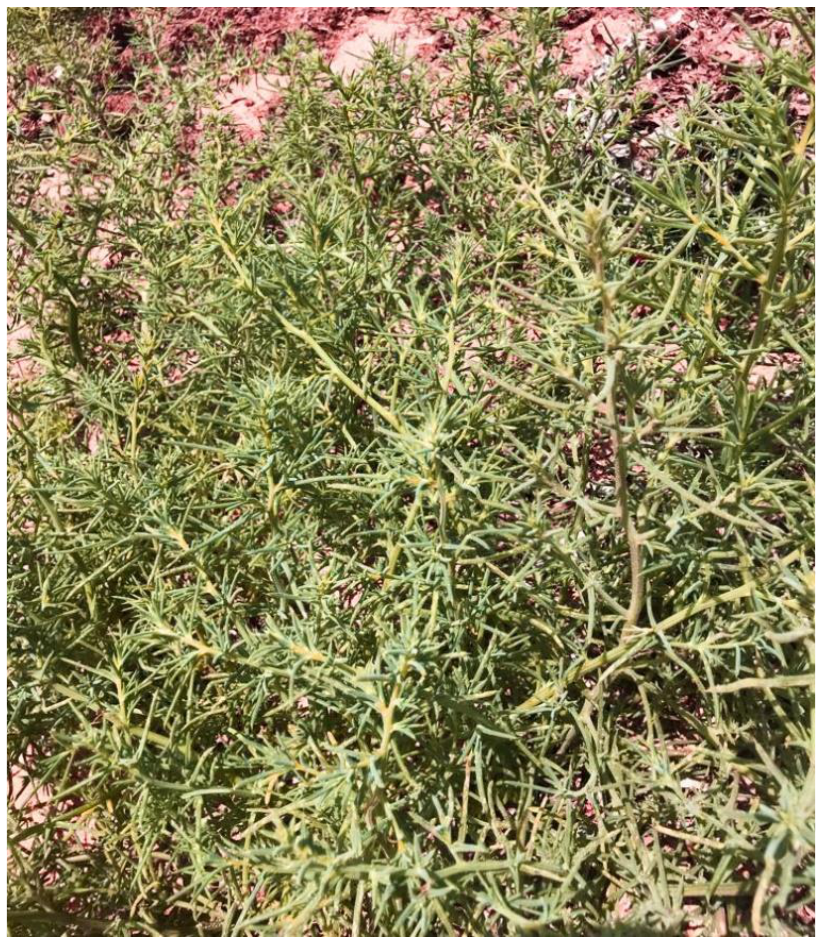
Figure 8. Soda inermis